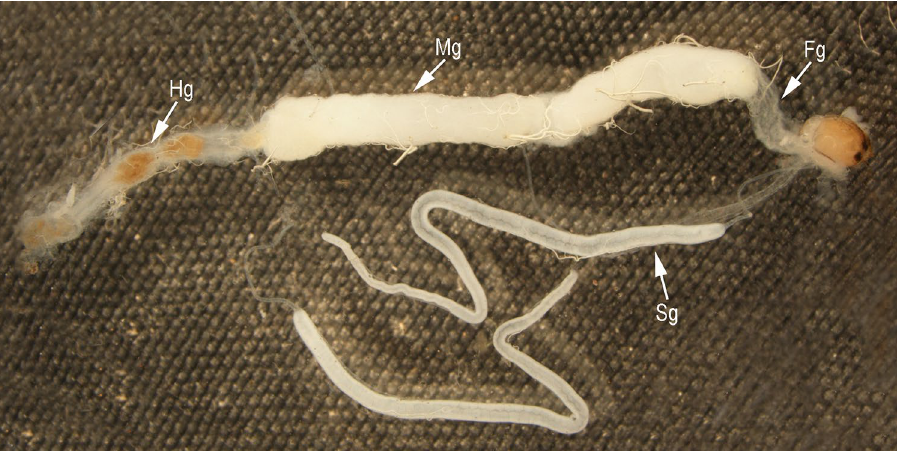
Figure 2. General structure of the gut and salivary glands of Chilo suppressalis . Fg, foregut; Mg, midgut; Hg, hindgut. Sg, salivary